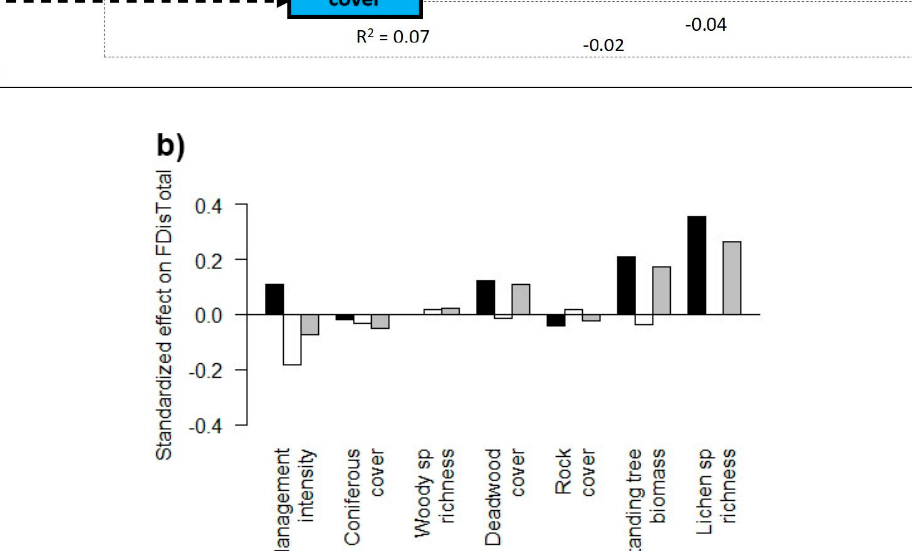
Figure 3. Effects of forest management and environmental variables on the functional diversity index considering all functional traits together (FDisTotal). ( a ) Structural equation model depicting the direct and indirect effects of forest management and conifer cover (orange boxes) on environmental variables (blue boxes) and lichen biodiversity (green boxes). Functional diversity was calculated for all traits (FDisTotal). Single-headed arrows indicate a direct effect of a given variable on another. Double-headed arrows indicate a mutual dependency between two variables. The numbers adjacent to the arrows show standardized path coefficients; the widths of the lines are proportional to the size of the path coefficients. Solid lines indicate positive and dashed lines negative relationships. Asterisks next to the path coefficients indicate p -values: ***, p < 0.001; **, p < 0.01; no asterisk, p ≥ 0.05 (n.s.). The dashed arrows show co-variances between factors. R 2 values denote the proportion of variance explained for the endogenous variables. ( b ) Direct effects (black bars), indirect effects (white bars) and standardized total effects (direct × indirect effect; grey bars) of all factors on FDisTotal, derived from the structural equation models.